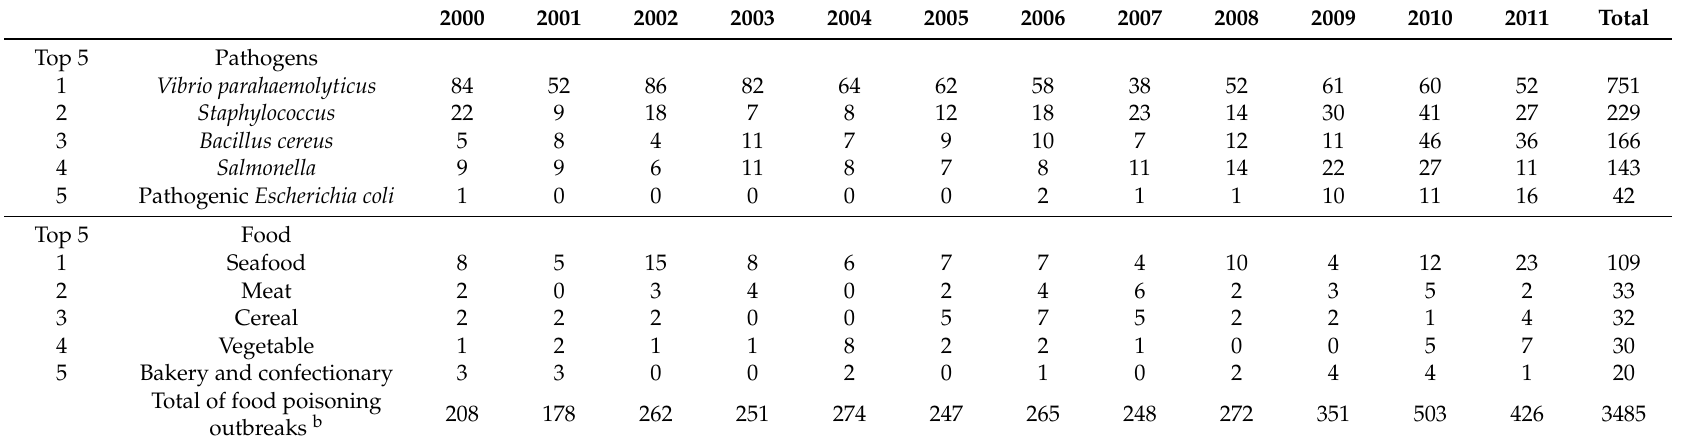
Table 1. Top five pathogens and foods in food poisoning cases from 2000 to 2011 in Taiwan a .